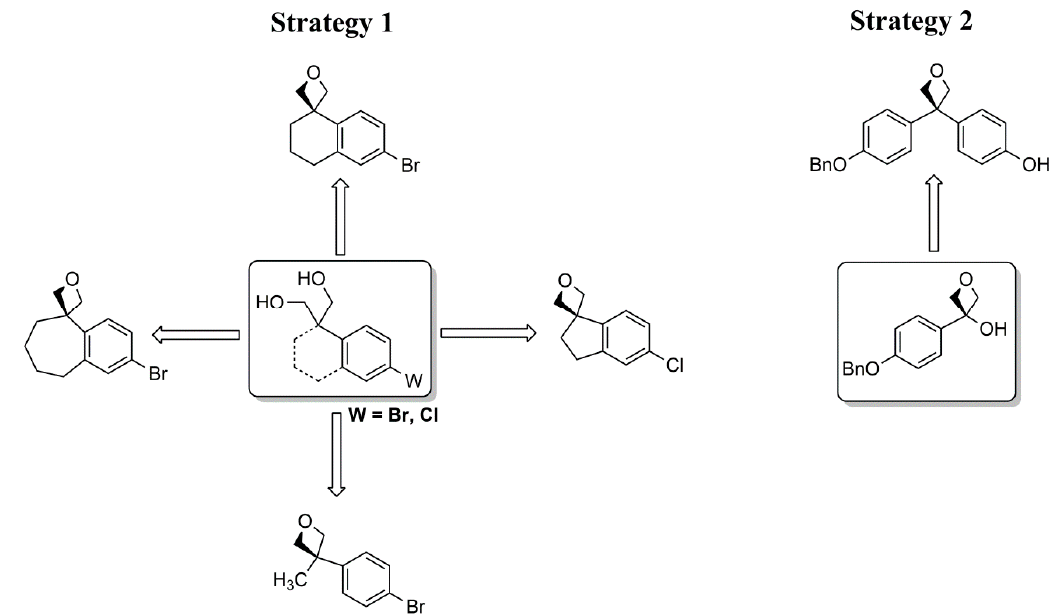
Figure 4. Strategies used to synthesize the oxetane scaffolds.